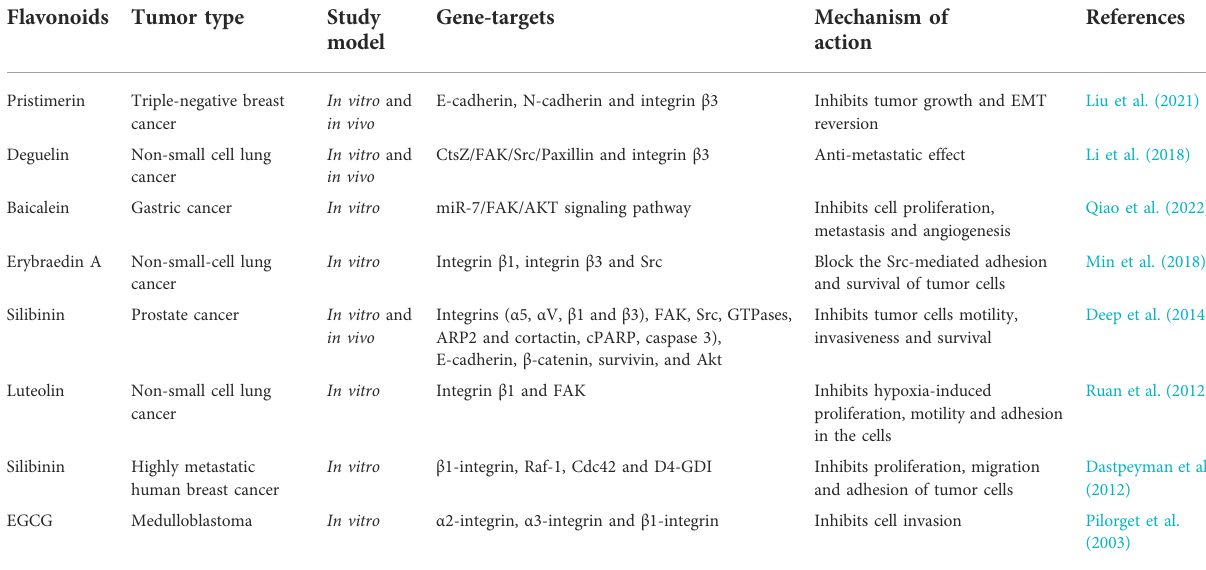
TABLE 7 The antitumor effect of fl avonoids by regulation of